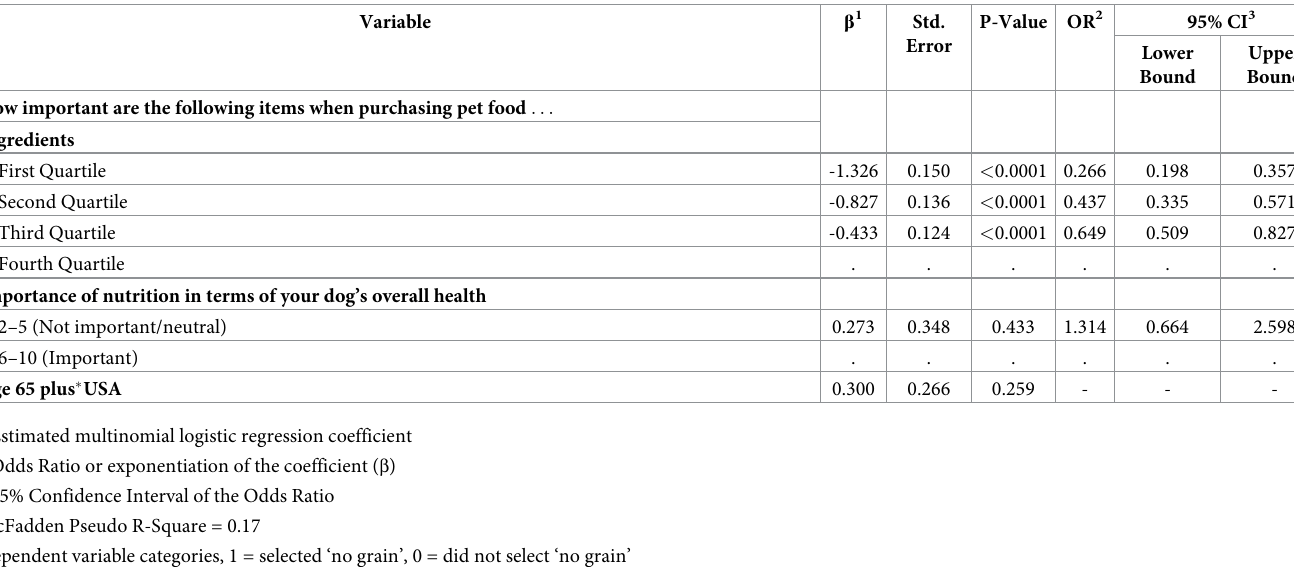
The Purchasing Habits Model ( χ 2 (26) = 438.75, P < 0.0001, Table 5) had a McFadden Pseudo R-Square value of 0.13. Again, people from France were less likely to select ‘no grain’ than people from the UK (P < 0.0001) and male respondents were less likely to select ‘no grain’ than female respondents (P = 0.002). People who purposely rotate their dog’s dry food to pro- vide variety were less likely to select ‘no grain’ (P = 0.021). Similar to the Diet Model, people who ranked the importance of ingredients on a pet food label in the first, second and third quartiles were less likely to select ‘no grain’ than those who ranked ingredients in the fourth quartile (P < 0.0001). People who selected that they get their information about pet food from online resources and/or pet store staff were 1.6 and 1.3 times more likely to select ‘no grain’ than those that do not get their information about pet food online or from pet store staff (P < 0.0001 and P = 0.006, respectively). People who purchase their dog food from a veterinary clinic, a pet specialty store and online were 2.2, 1.6 and 2.4 times more likely to select